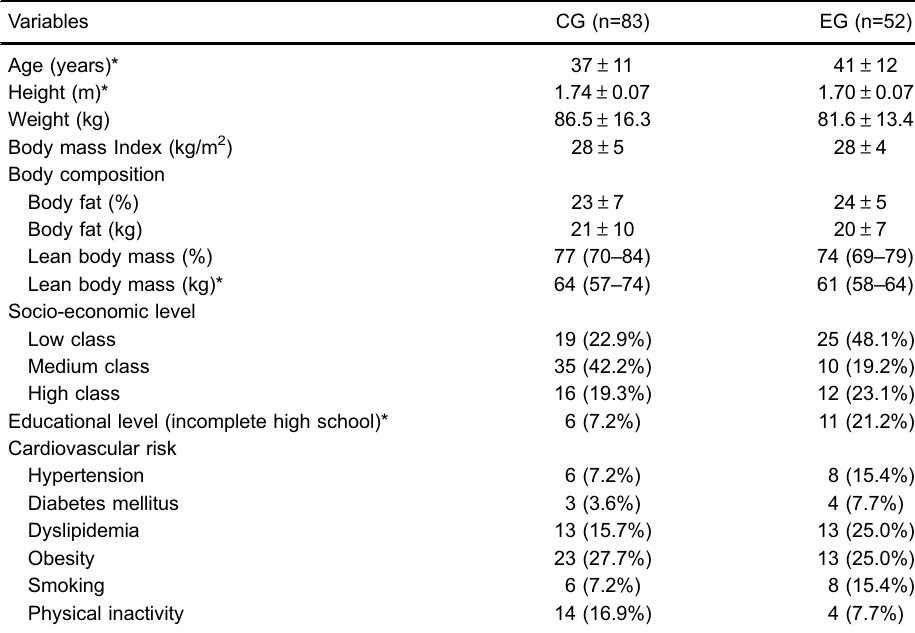
Table 1. General characteristics of the participants according to occupational exposure to particulate matter.